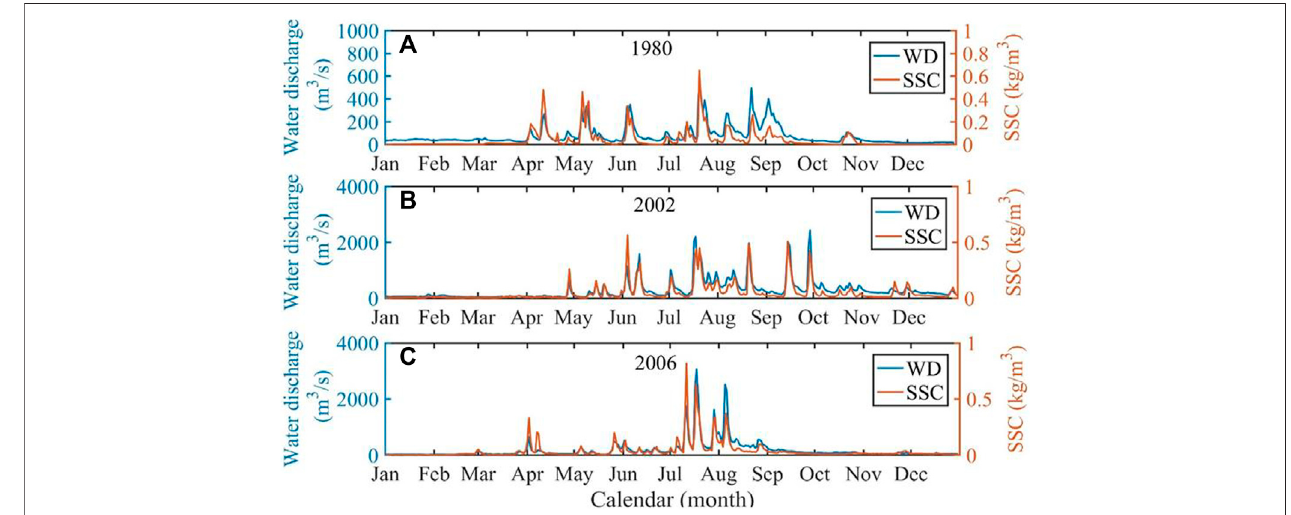
FIGURE 11 | Relationship between the SSC and water discharge (A) dry year of 1980; (B) fl ood year of 2002; (C) fl ood year of 2006.